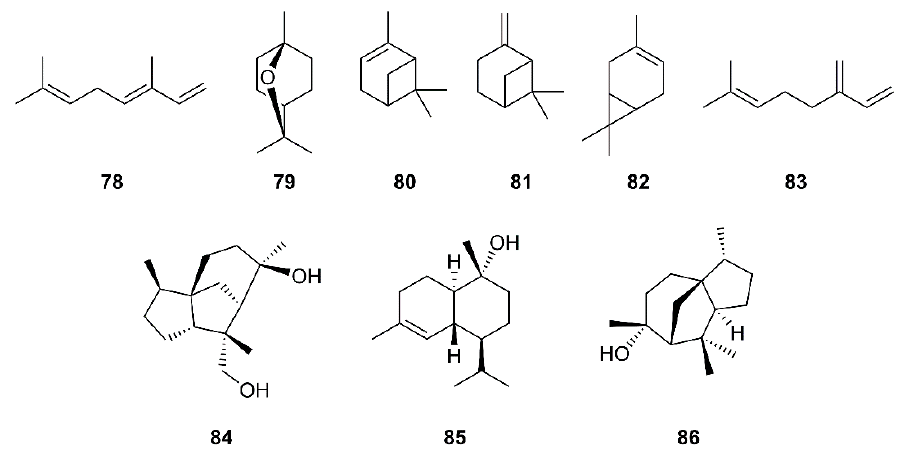
Figure 14. Structures of monoterpenes 78 – 83 and sesquiterpenes 84 – 86 .